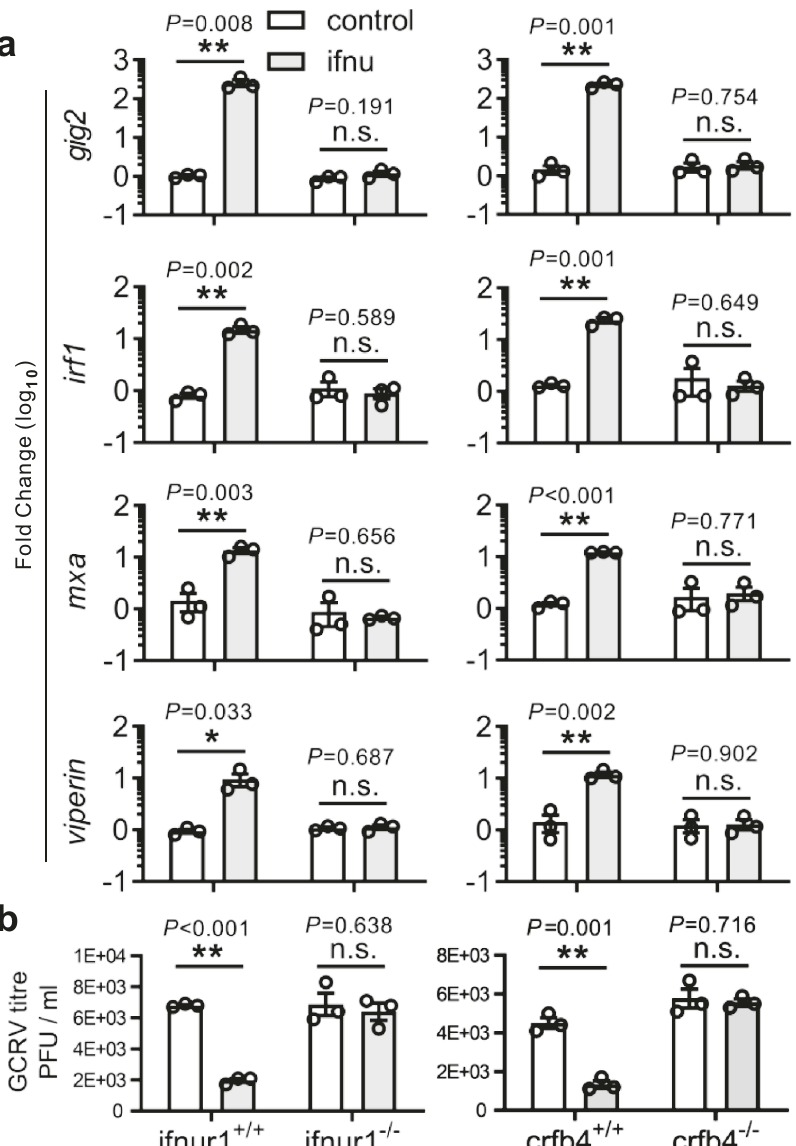
Fig. 4 Knockout effect of ifnur1 and crfb4 on zebra fi sh IFN- υ signaling. Analyses of ISG expression ( a ) and viral titer ( b ) in ifnur1 and crfb4 de fi ciency and WT zebra fi sh stimulated by IFN- υ . Embryos ( n = 150) at one-cell stage were micro-injected with IFN- υ or control plasmids for 72 h, and hatched zebra fi sh larvae ( n = 33) were collected for quantitative RT-PCR detection or infected with GCRV for 24 h to determine viral titer. The expression of ISGs was normalized against gapdh . Data are expressed as mean ± SEM from three independent experiments. The two-tailed Student ’ s t test was used to determine the statistical signi fi cance, with * indicating P < 0.05, and ** indicating P < 0.01, n.s. non-signi fi